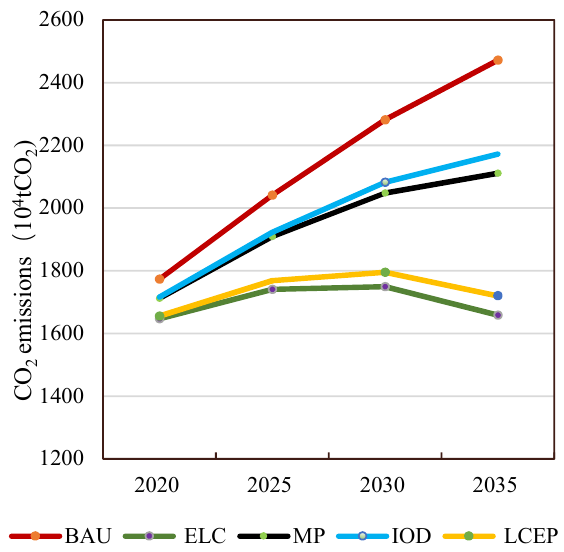
Figure 5. CO 2 emissions forecast for Changxing County. BAU: business as usual, ELC: enhanced low-carbon, MP: moderate progressive, IOD: industry-oriented development, and LCEP: low-carbon development in the electric power sector.